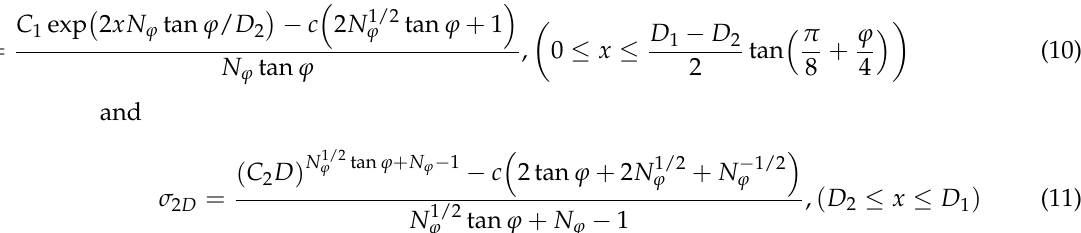
These two differential equations can be solved separately to obtain